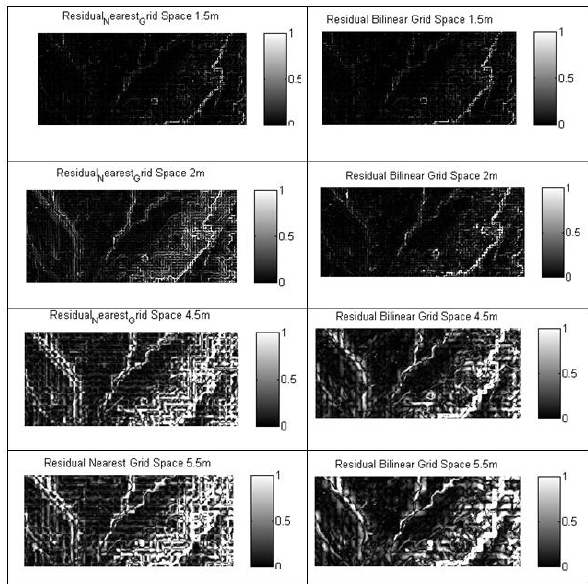
Figure11, Error values on DEM pixels at each interpolation algorithm(Left plot: Nearest neighbor interpolation, Right plot: Bilinear interpolation)